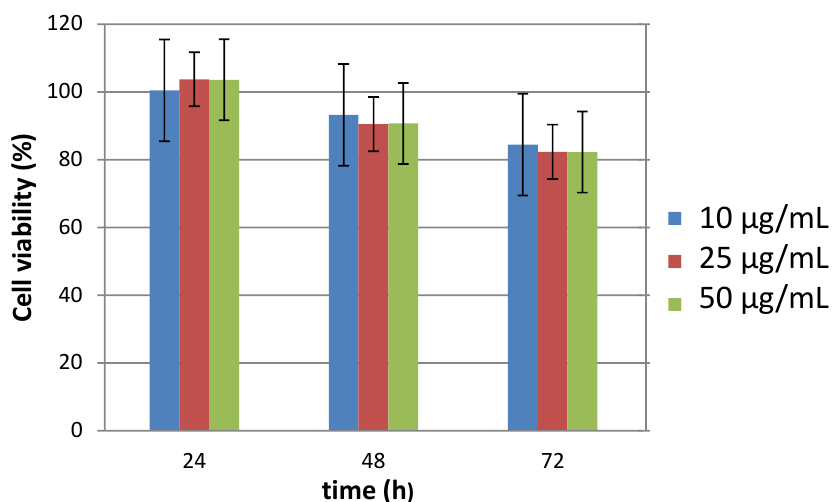
Figure 9. Relative number of viable BJH cells, determined using the Alamar blue test when exposed to different doses of citrated β-NaY 0.8 Eu 0.2 F 4 @γ-Fe 2 O 3 particles for different contact times. The results were expressed as a ratio to non-stimulated serum-free cultured cells for dose point. (Analysis of variance (ANOVA) test p ≤ 0.05).